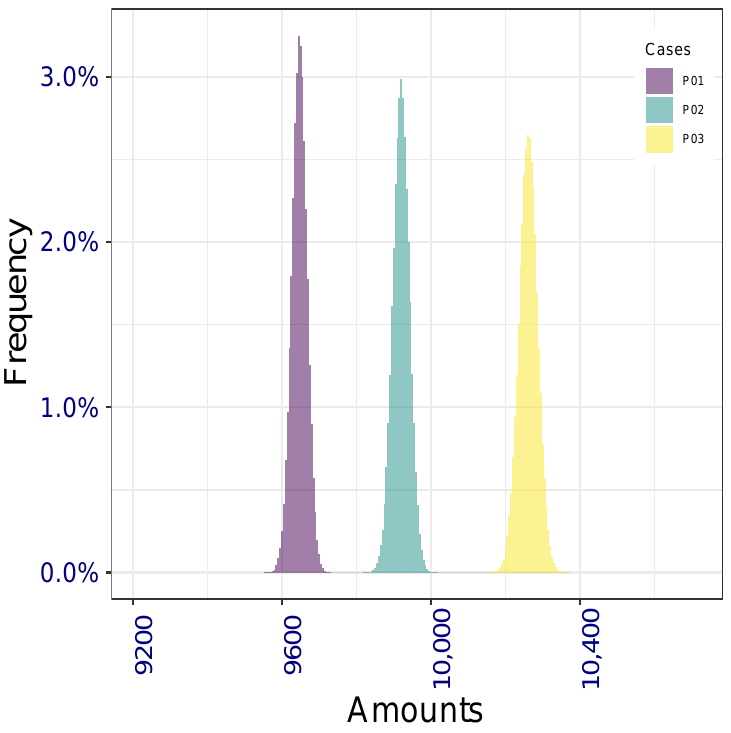
Figure 4. Impact of the number of enhanced annuities: empirical distributions of the annual benefit payout at time t =